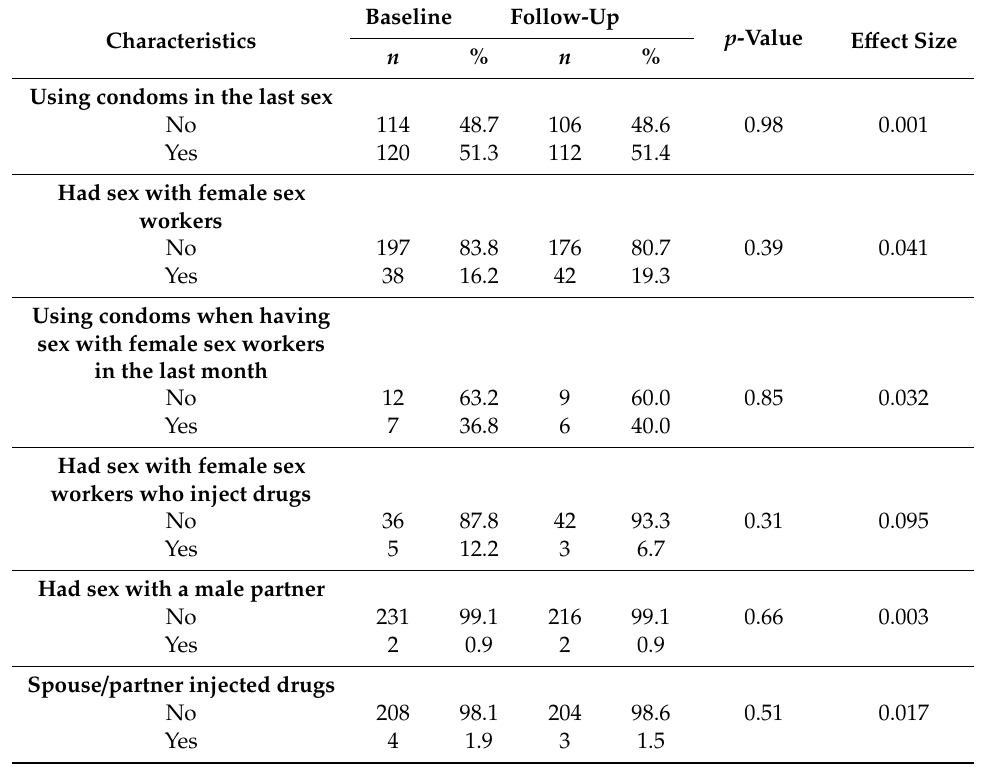
Table 4. Changes in sexual behaviors among methadone maintenance treatment